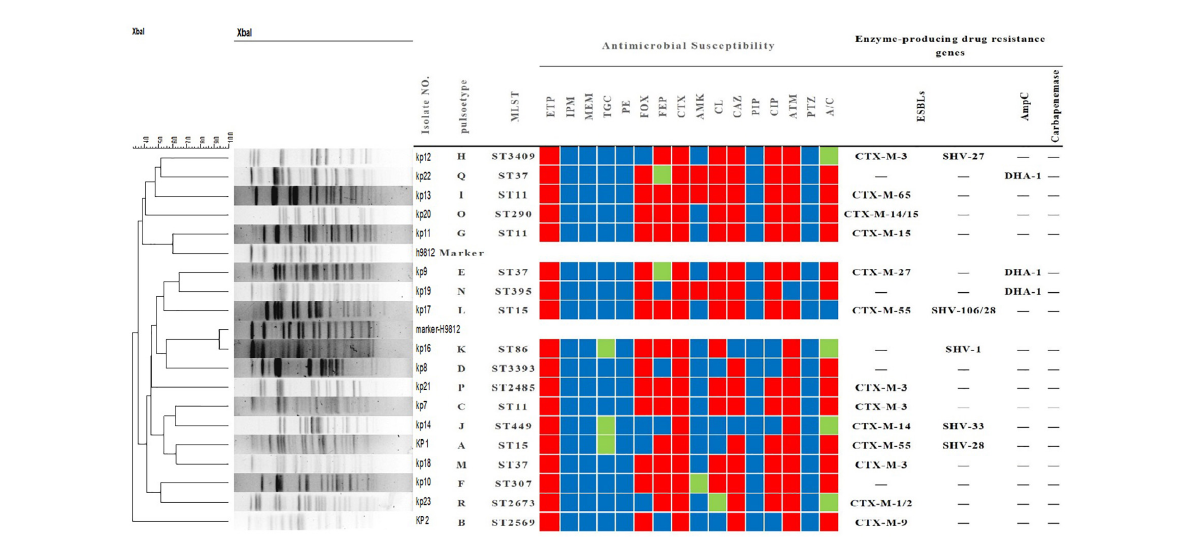
FIGURE1 Tree diagram of 18 strains of Klebsiella pneumoniae resistant only to ertapenem based on pulse field gel electrophoresis, multilocus sequence typing, characterization, drug sensitivity spectrum and drug resistance gene profile. MLST, multi-locus sequence typing; ETP, ertapenem; IPM, imipenem; MEM, meropenem; TGC, tigecycline; PE, polymyxin; FOX, cefoxitin; FEP, cefepime; CTX, cefotaxime; AMK, amikacin; CL, chloramphenicol; CAZ, ceftazidime; PIP, piperacillin; CIP, ciprofloxacin; ATM, aztreonam; PTZ, piperacillin-tazobactam; A/C, amoxicillin-clavulanic acid. The red, green, and blue squares indicate resistance, intermediate resistance, and susceptibility to each antibiotic, respectively.